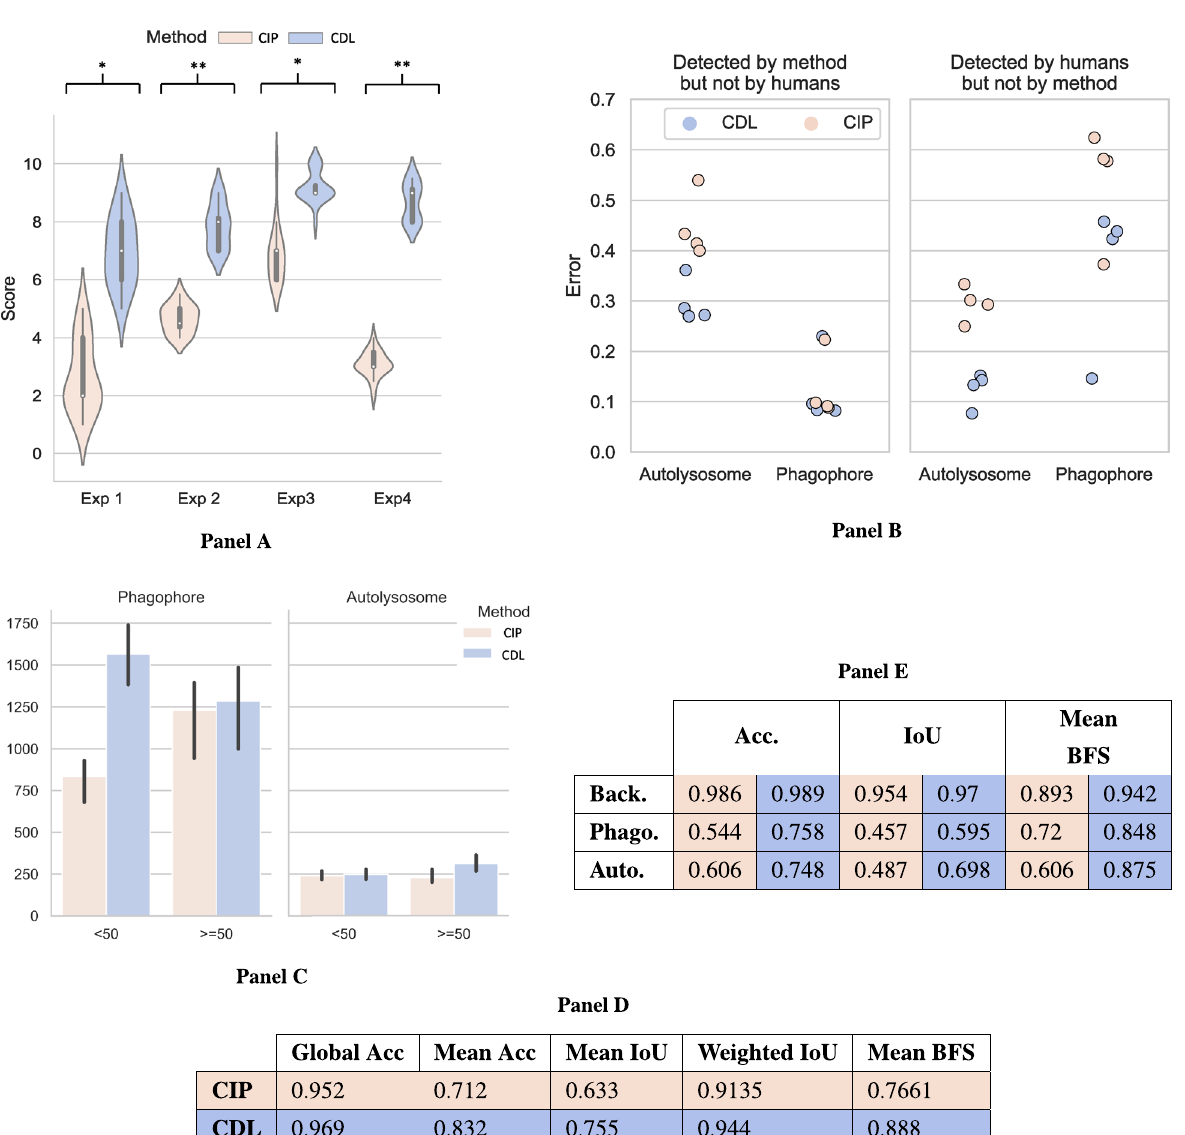
Figure 3. Measuring Deep learning (DL) generalisation robustness with noisy label data for semantic segmentation. Result of the three complementary methods assessing the Convolutional Neural Network (CNN) capacity of overcoming segmentation errors. Comparison of CNN deep learning (CDL) prediction and Conventional image processing (CIP, Method for label generation). ( A ) Results of the qualitative analysis: Expert rating. Violin plots represent the distribution of the score given to each method in the double-blinded test.The CDL method scored significantly higher in all the expert. ( B , C ) Results of the quantitative analysis: Detection as a surrogate metric. ( B ) Scatter plots representing the misclassification ratio of a method (CIP or CDL) compared to human annotations. Each point represents the result of a given expert for a given class and method. Therefore, there are 4 points, one for each expert, per class and method. The highest the error ratio, the worse the method performance. ( C ) Results of the quantitative analysis: Detection as a surrogate metric. Plots represent the average number of Bounding Box intersections between the manual reference generated by the four experts and the evaluated method. Error bars represent standard deviation. Overlapping levels split as follows: On the left, lower overlap (between 0.1 and 0.49) and on the right, higher overlap (0.5 to 1). For both classes (Phagophore and Autolysosome) and both overlapping ranges, the number of detected events is higher in the CDL segmentation than in the CIP one. ( D , E ) Results of the quantitative analysis: Detection as a surrogate metric CIP results are presented in light orange, CDL results in dark blue. ( D ) Aggregated metrics. ( E ) Metrics broken-down per class. The CDL method showed a better performance in line with the results obtained with the previous